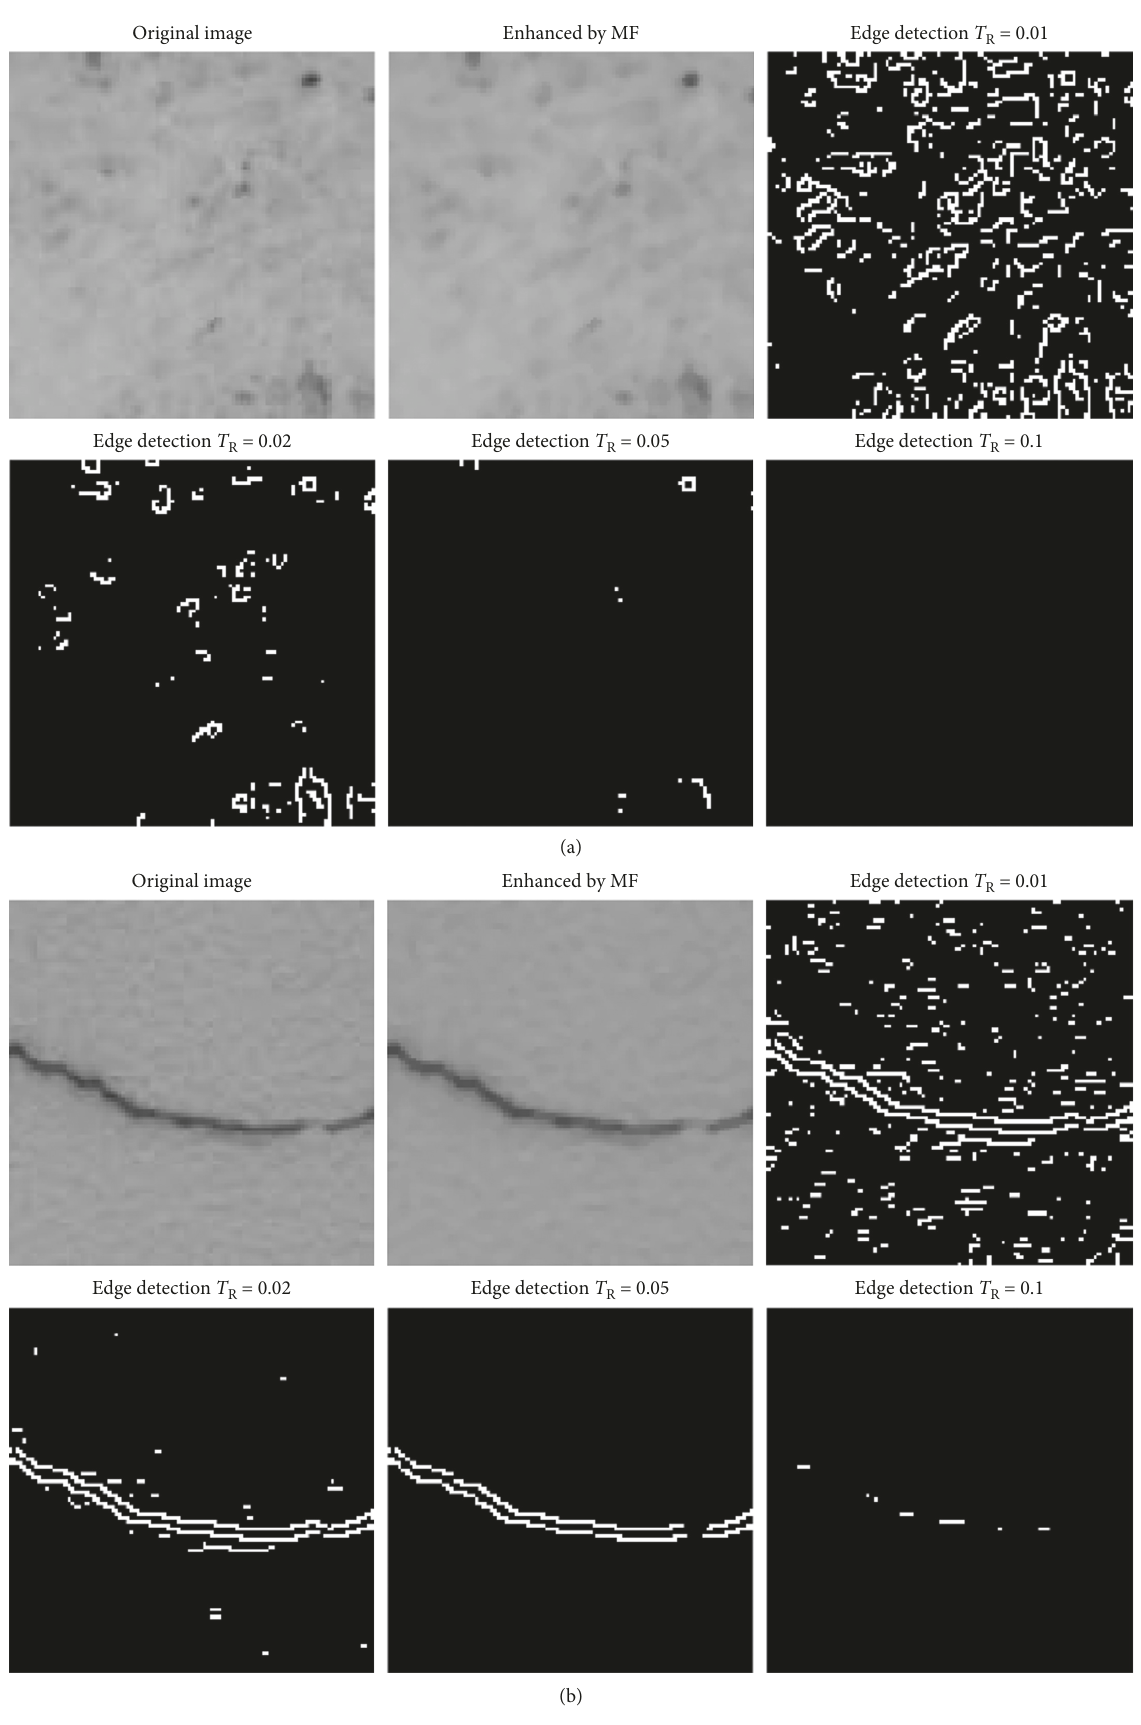
Figure 1: Edge detection result using the Roberts method: (a) an image without cracks and (b) an image with